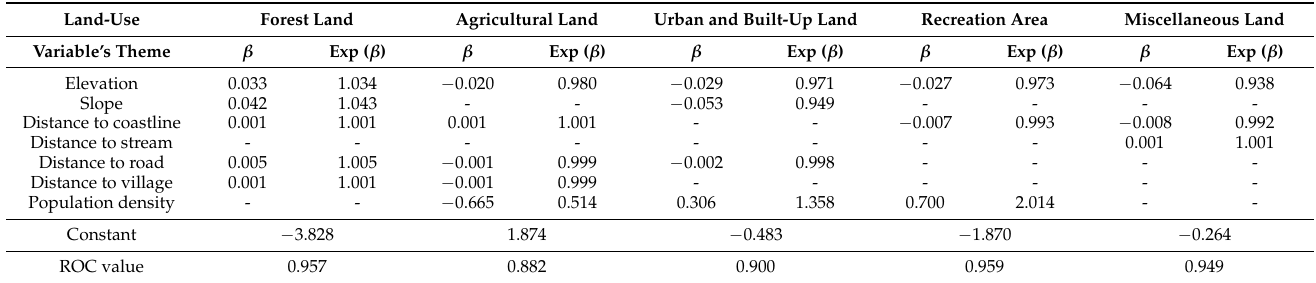
Table 5. Logistic regression results of the spatial distribution of LUC in Koh